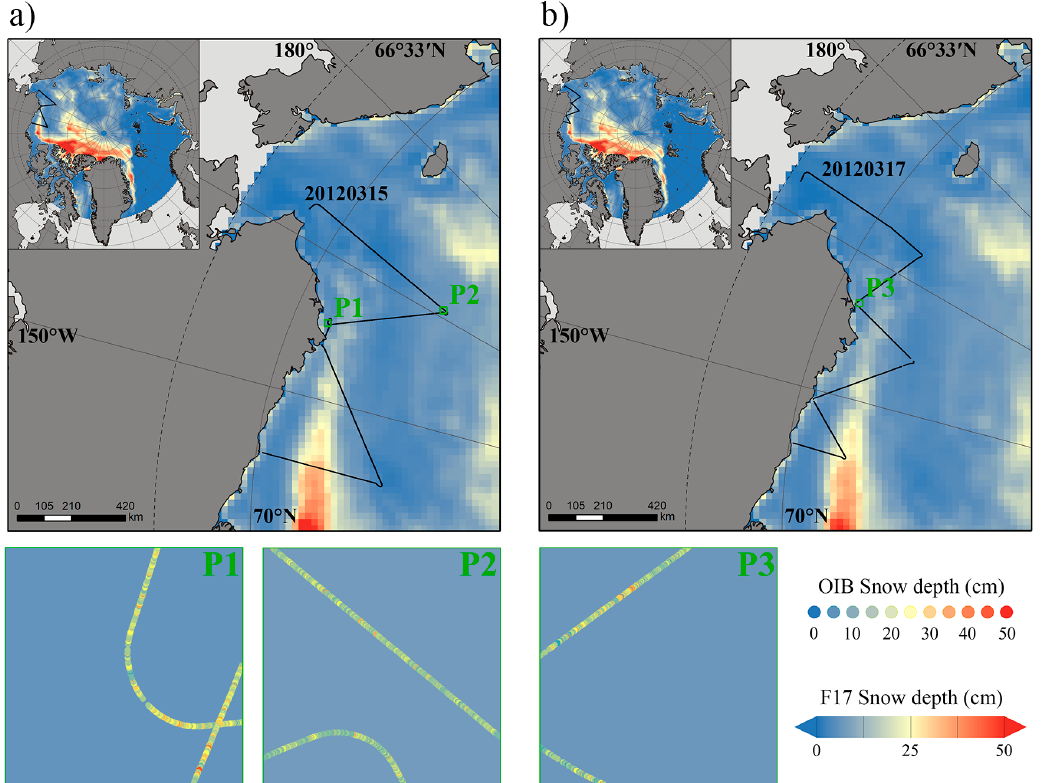
Figure 3. Transects of OIB SD measurements on 100% first-year sea ice. The background represents the F17 SD at 25 km resolution. ( a ) represents the transects on 15 March 2012, north of the Alaska, and the two transects across the F17 SD 25 km pixels (referenced P1 and P2); ( b ) represents the transects on 17 March 2012, north of the Alaska, and the two transects across the F17 SD 25 km pixel (referenced P3).